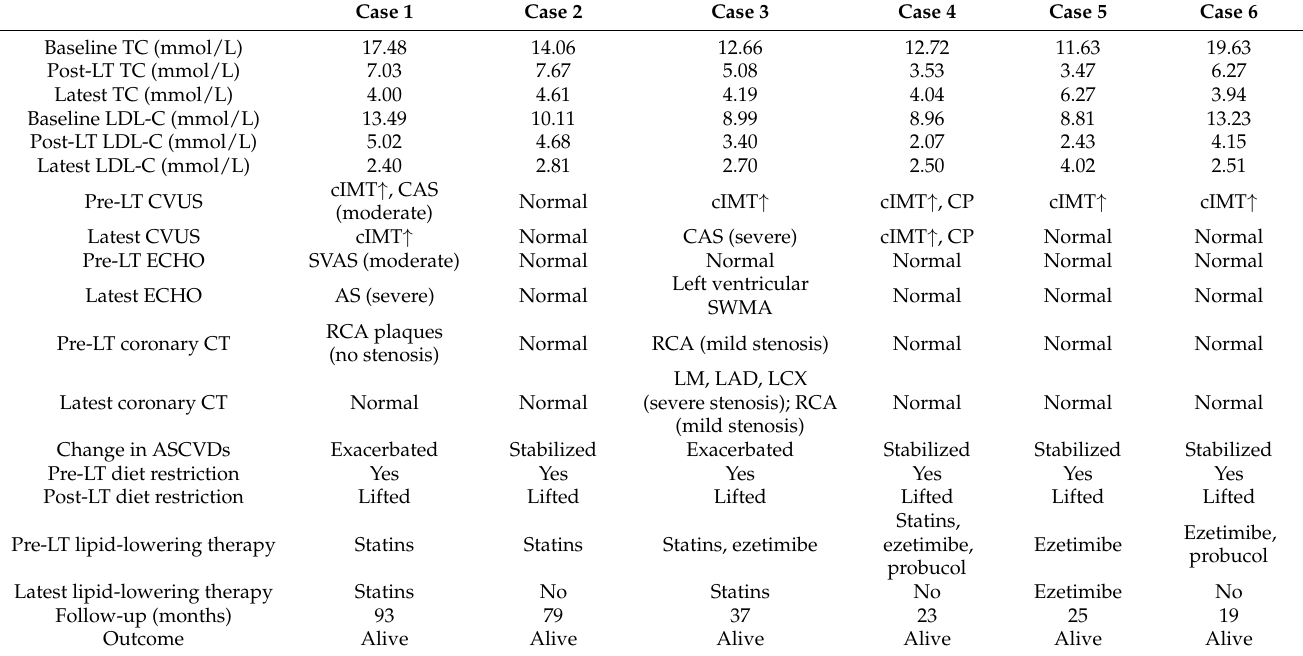
Table 2. Lipid profiles, ASCVDs, diet restriction, and lipid-lowering therapy before and after